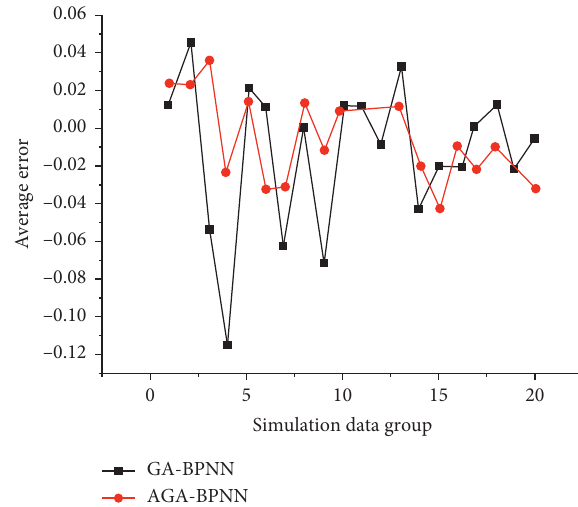
Figure 5: Comparison on average output error of the standard GA- BPNN and AGA-BPNN.